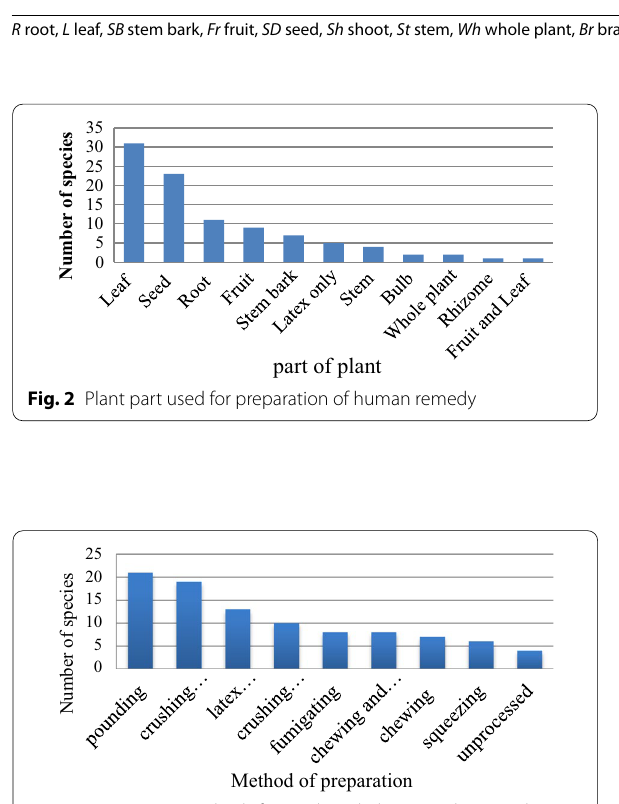
Fig. 3 Preparation methods for medicinal plants used to treat